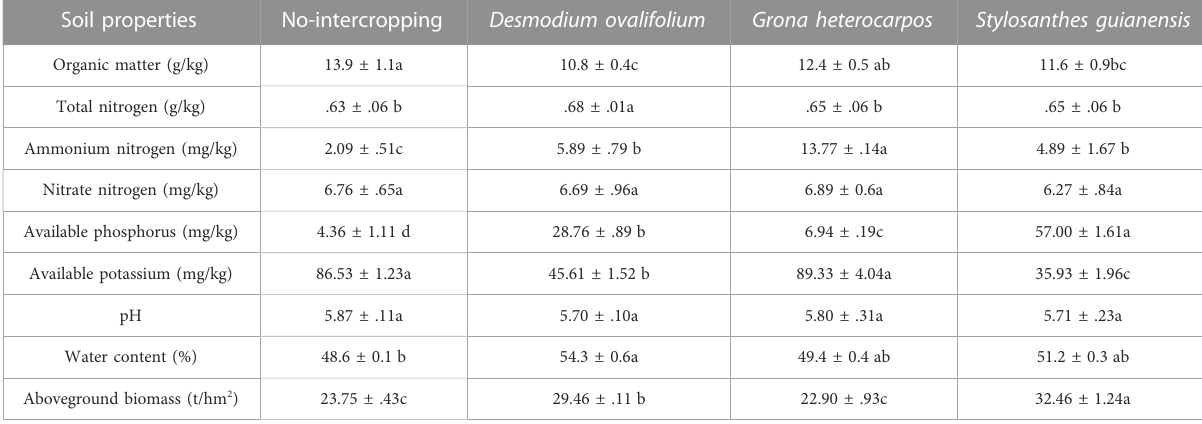
TABLE 2 Chemical properties and nutrient contents of soil in litchi orchard grown without intercropping or with Stylosanthes guianensis , Desmodium ovalifolium , and Grona heterocarpos intercropping. Soil properties